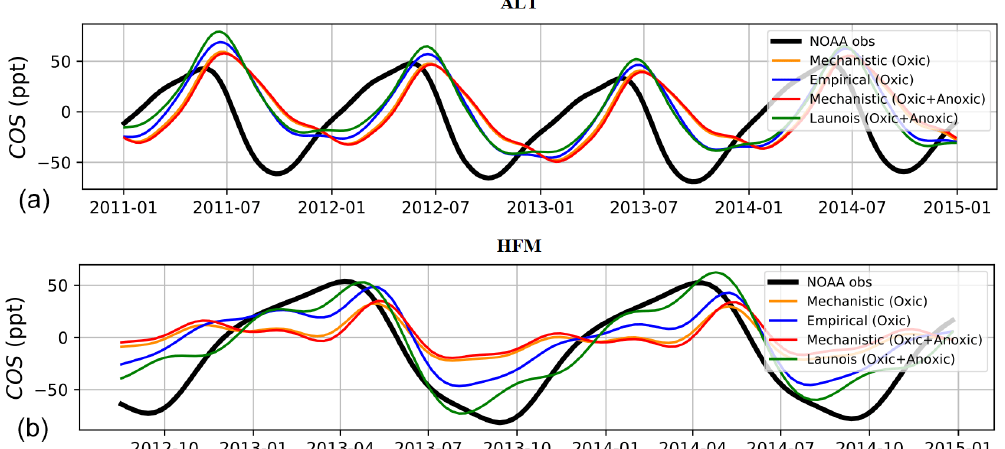
Figure 10. Detrended temporal evolution of simulated and observed COS concentrations at two selected sites, simulated with LMDZ6 transport between 2011 and 2015. The simulated concentrations are obtained by transporting the surface fluxes described in Table 2 and changing only the contribution from soils, with mechanistic (oxic soils alone and oxic + anoxic soils) and empirical approaches (Berry et al., 2013; Launois et al., 2015). (a) Alert station (ALT, Canada) and (b) Harvard Forest station (HFM, USA). The curves have been detrended beforehand and filtered to remove the synoptic variability (see Sect. 2.3.3). Please note that the date format in this figure is